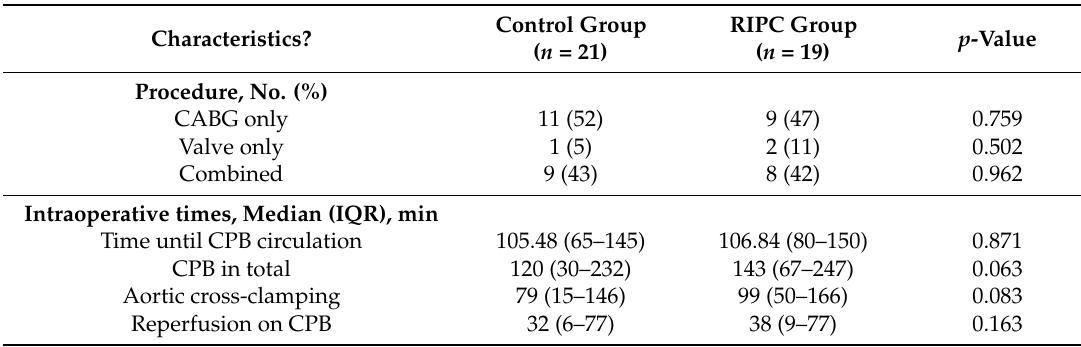
Table 2. Operative